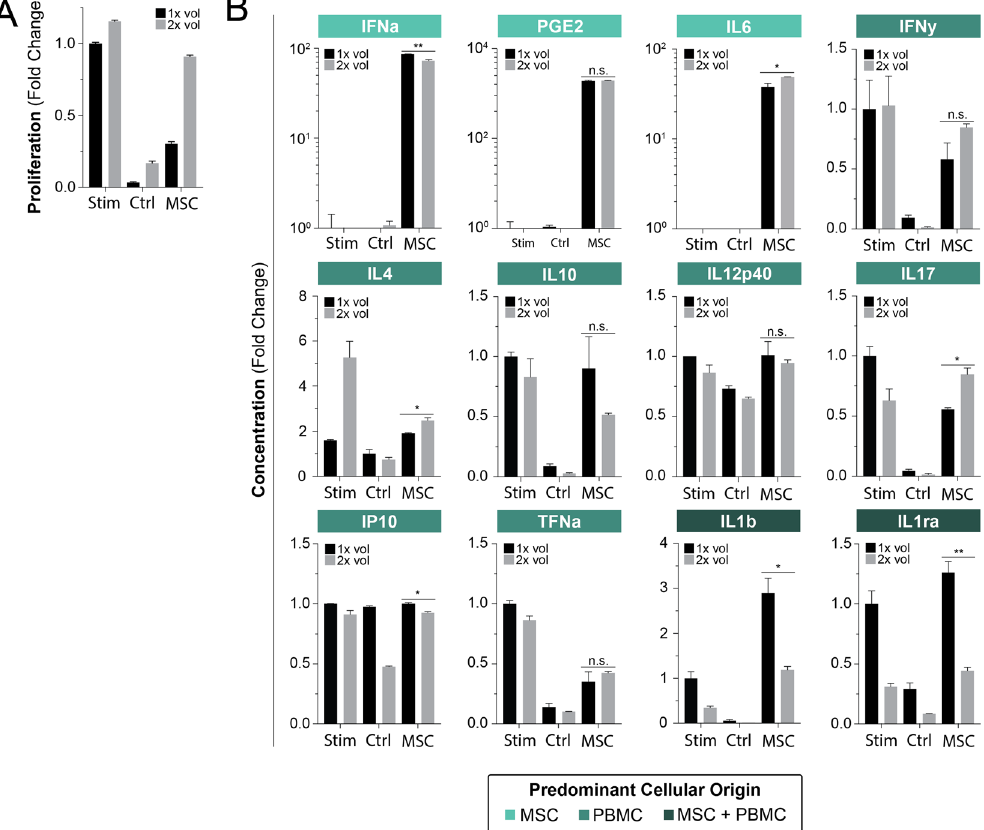
Figure 4. Volume is an implicit microenvironment factor driving MSC potency. PBMC proliferation was attained through stimulation with ConA and IL2 for a period of 4 days. Proliferation was measured through flow cytometry and CFSE staining; bar graphs represent mean + / − SD of 3 samples. (A ) Bar graphs of normalized proliferation versus culture volume conditions. ( B ) Bar graphs of normalized cytokine secretion versus culture volume conditions. Two-group significance comparisons were performed with a student’s T-test; n.s., no significance; * P ≤ 0.05; ** P ≤ 0.01; *** P ≤